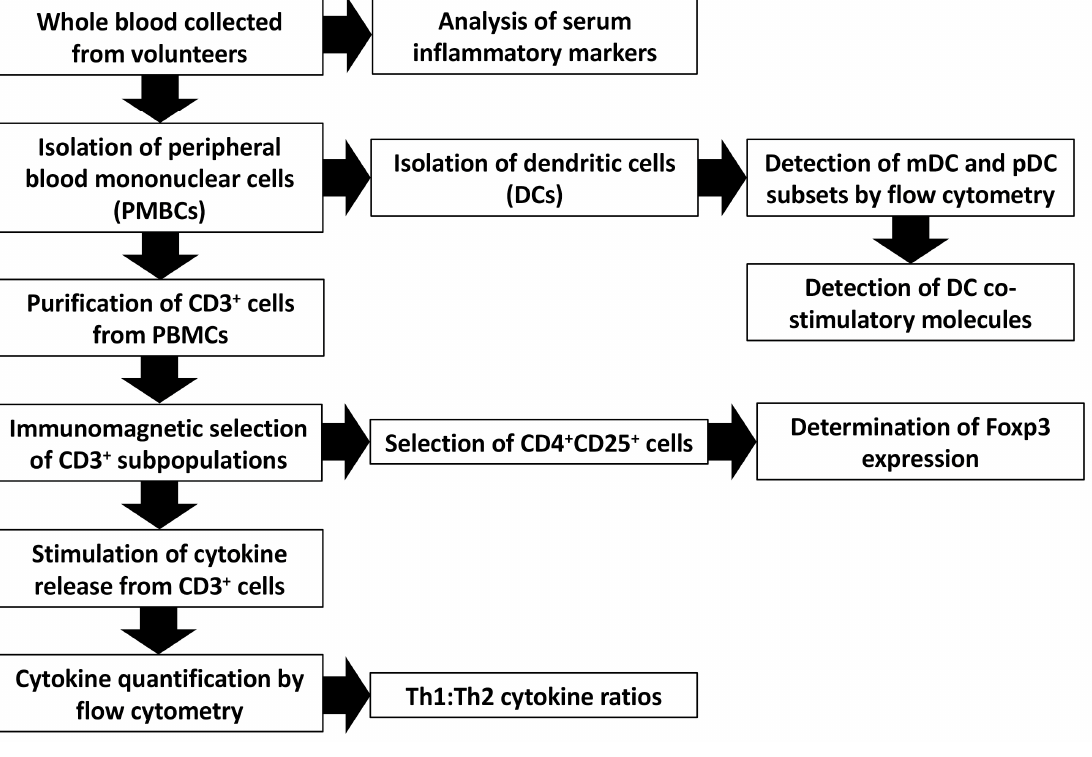
Figure 1. Outline of methods used to isolate immune cells and cytokines. Foxp3: forkhead box P3; mDC: myeloid dendritic cells; pDC: plasmacytoid dendritic cells; Th: T helper.